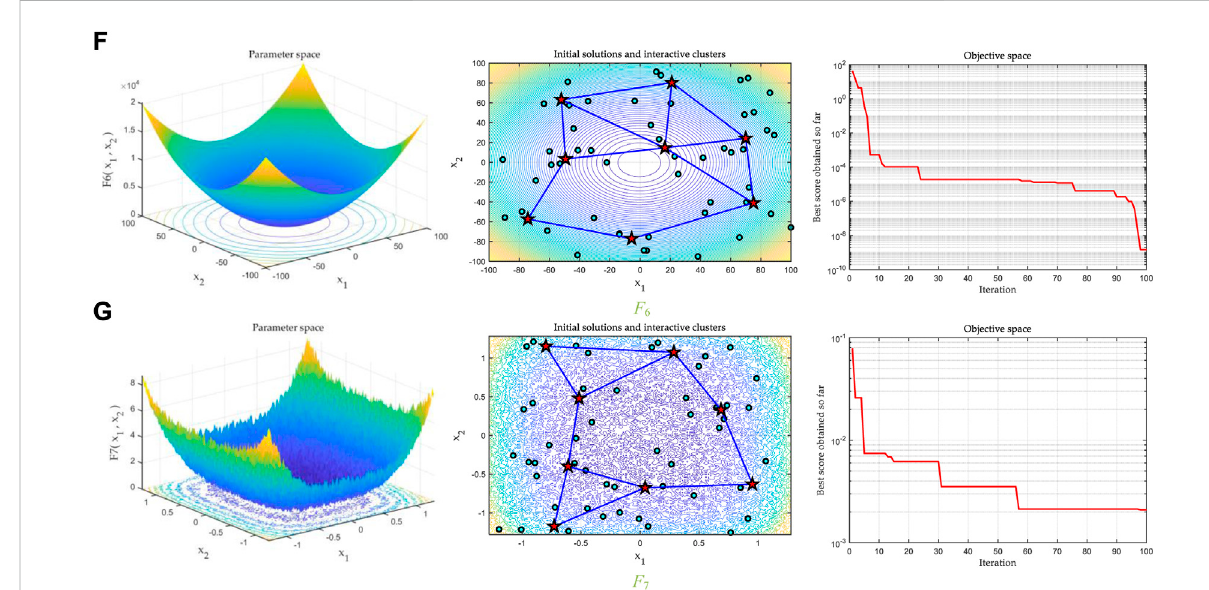
Function Metrics